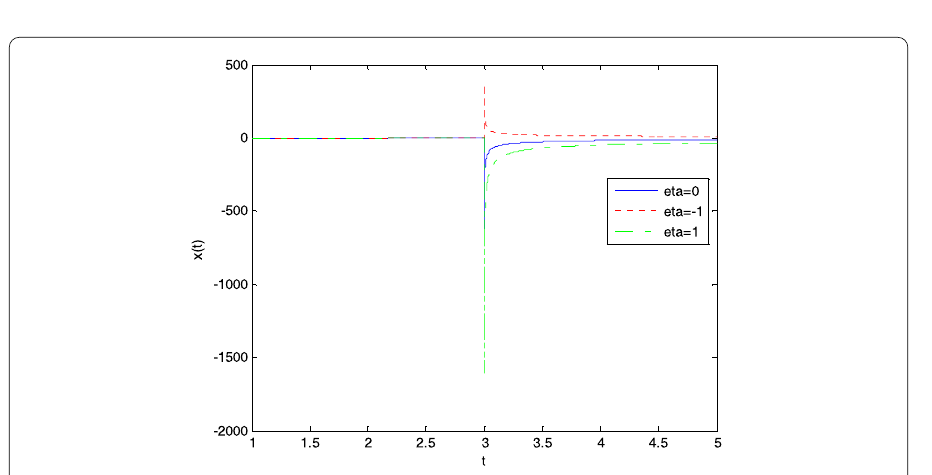
Figure 5 The solution trajectory of system (5.2) with ρ =